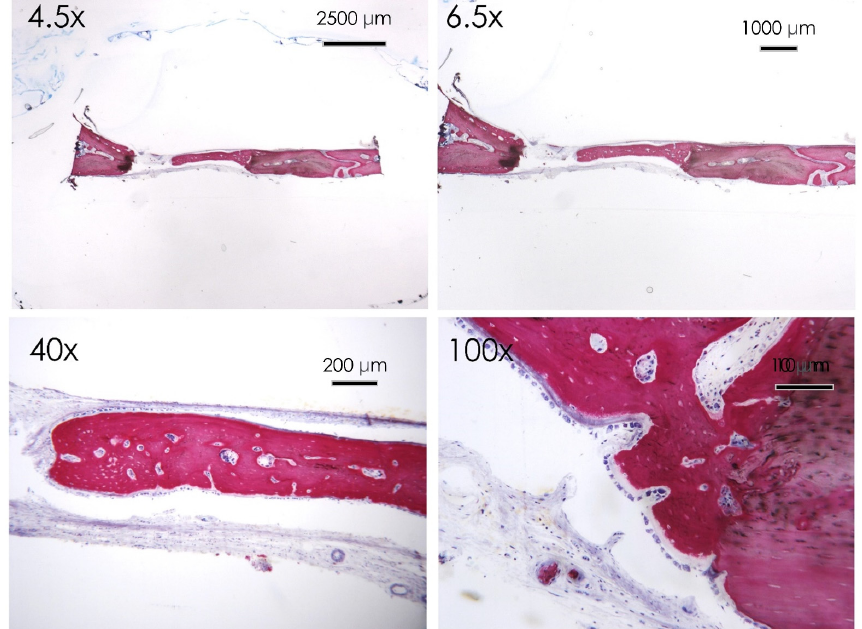
Figure 7. Apigenin group. Histological section of the calvaria bone specimens at different magnifications (4.5×, 6.5×, 40×, and 100×). A consistent filling of the bone defect was evident after 30 days of apigenin administration.